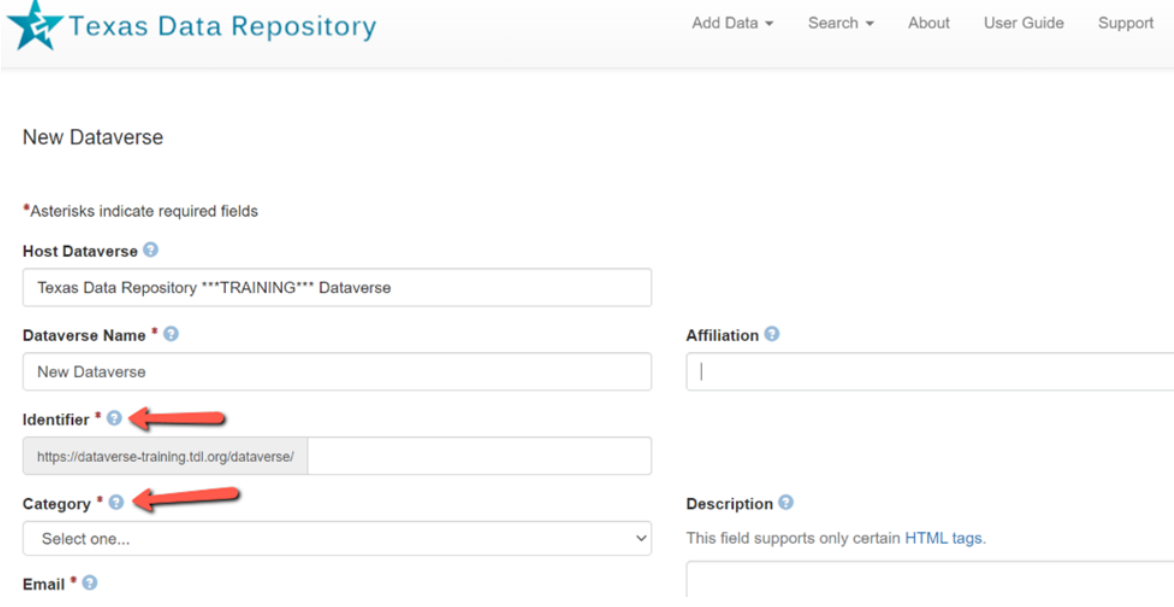
Figure 3 : Identifier and Category